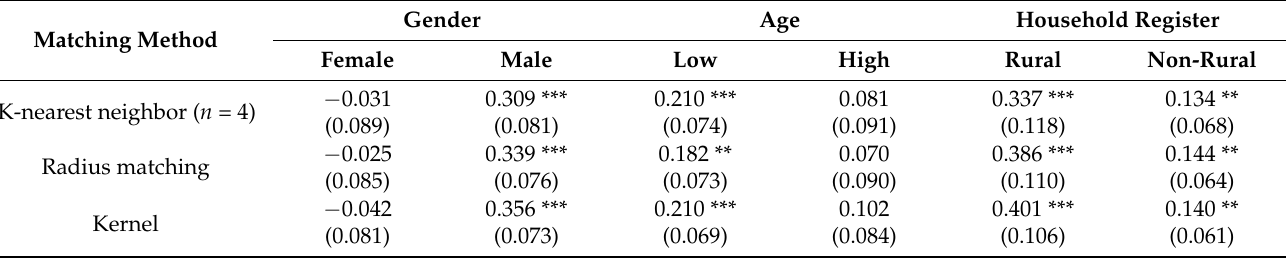
Table 8. Results of heterogeneity analysis. (PSM Estimate).